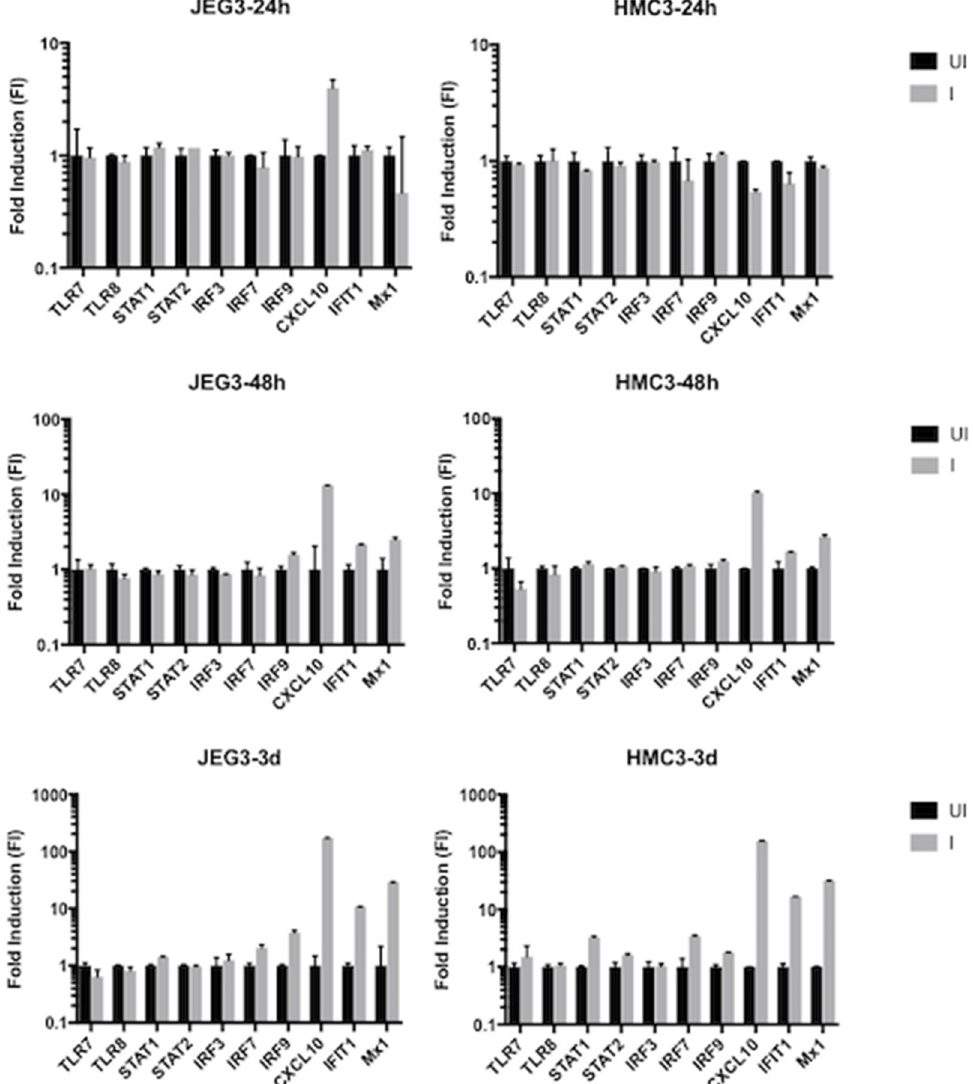
Figure 4. Fold induction values for genes involved in the innate immune response of time-matched mock-infected (UI) versus ZIKV-infected (I) HMC3 and JEG-3 cells at 24 h post infection (hpi), 48 hpi, and three dpi. Values were determined by calculating the fold induction (FI) using the delta-delta cycle threshold ( ∆∆ Ct) method for each gene, normalizing the values for each gene to the UI results.